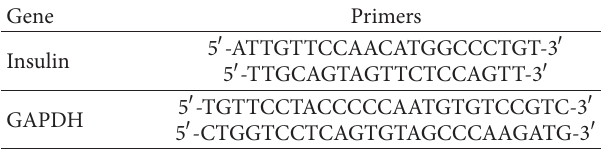
Table 1: Primer sequences of genes encoding insulin and GAPDH. Gene